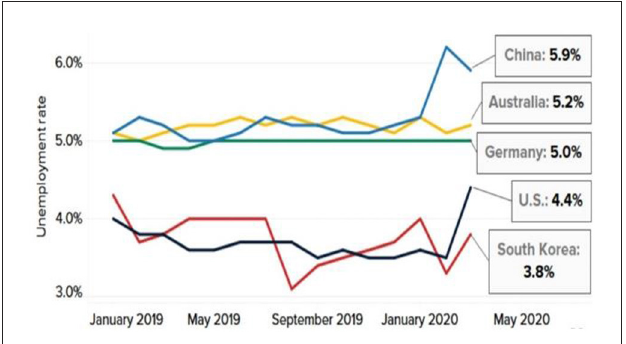
FIGURE5 Coronavirus padamic hit jobs. Source: Bureau of Labor Statistics of the U.S.; National Bureau of Statistics of China, Deutsche Bundesbank, Australian Bureau of Statistics, Statistics Korea, Refinitiv.